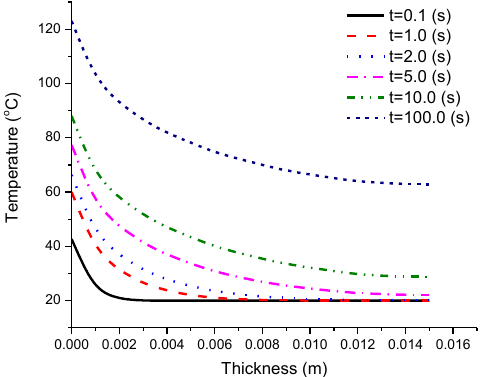
Fig. 4. The temperature distribution along the ring thickness on the radius r for different time values